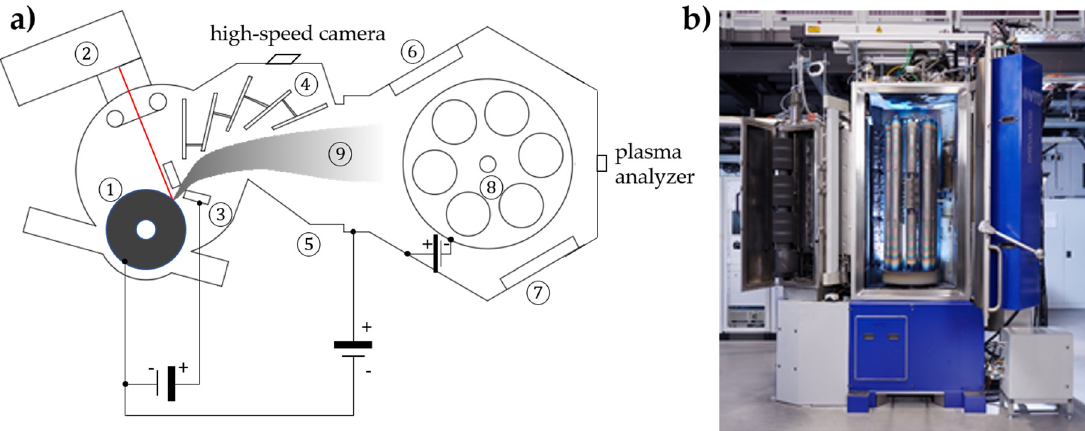
Figure 1. ( a ) Scheme of the coating systems with (1) graphite cathode, (2) laser scanner, (3) anode, (4) filter, (5) cham- ber/ground, (6) radiation heater, (7) magnetron, (8) substrate rotation, and (9) carbon plasma. ( b ) View of the coating system.